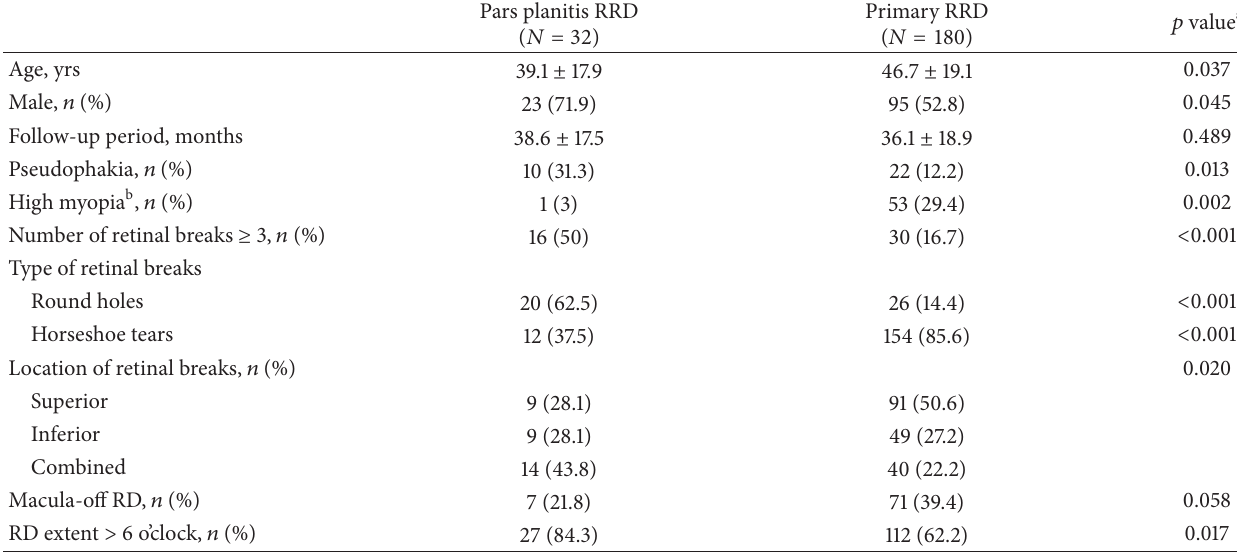
Table 1: Demographics and baseline characteristics of pars planitis associated rhegmatogenous retinal detachment (RRD) patients and primary RRD